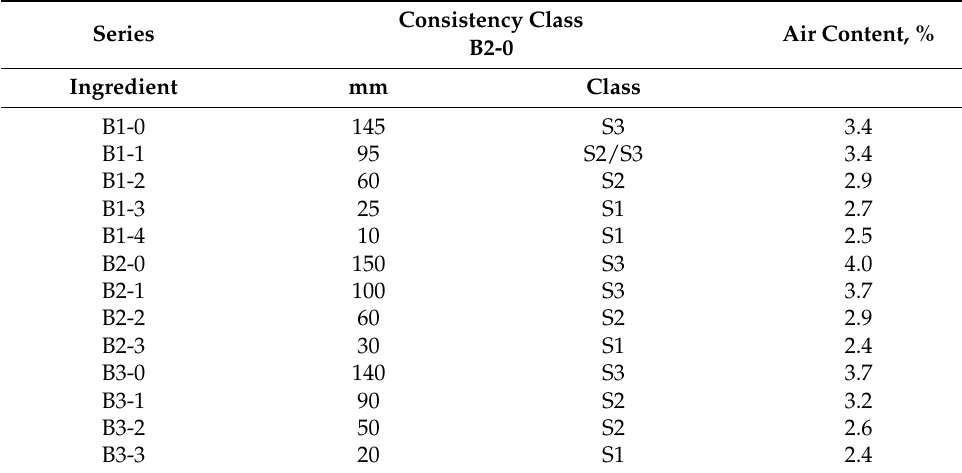
30% ash (Table 4). Mixes with the sand–basalt aggregate behaved similarly to the B1 mixes, too. The addition of fly ash to concrete mixes based on CEM II cement (B3 series) also caused the condensation of the concrete mix and a reduction of the air content. Table 4. Consistency class and air content of B1, B2 and B3 concrete mixtures. Table 4. Consistency class and air content of B1, B2 and B3 concrete mixtures.